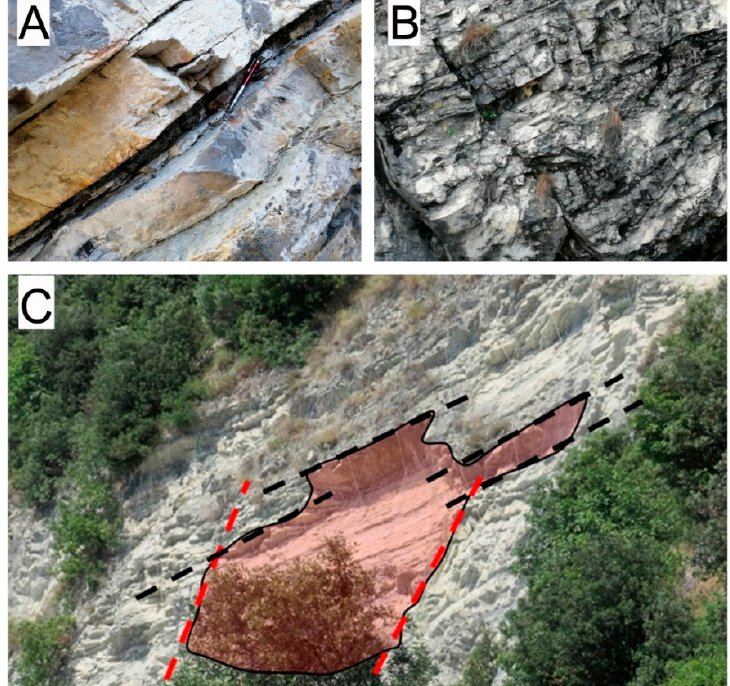
Figure 16. ( A ) Marly layers and bedding planes in limestones often not detectable by non-contact methods. ( B ) High-angle discontinuities fracturing bedded limestones and contributing to the small size of blocks observed onsite. ( C ) A big volume of rock mass isolated by the intersection of the most spaced discontinuity sets with the bedding.